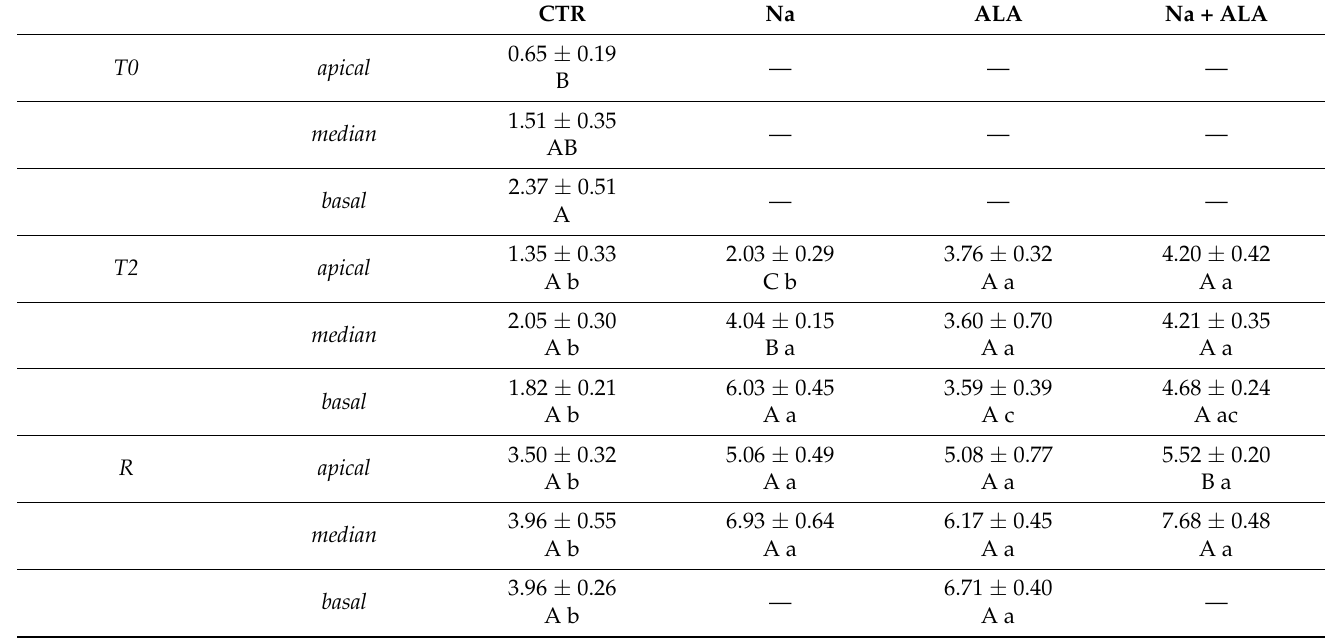
Table 4. Concentration of 5-aminolevulinic acid (ALA) ( µ g/g) measured at different time points (T0, T2, and R) in apical, median, and basal leaves of Arundo donax controls (CTR), salt-stressed (Na), ALA-treated (ALA), and both salt-stressed and ALA-treated (Na + ALA) plants. Mean values ± SE are shown. At any time-point, uppercase letters indicate statistically significant differences between (apical, median, and basal) leaves of plants undergoing the same treatment, and lowercase letters indicate statistically significant differences between (apical, median, and basal) leaves of plants undergoing different treatments ( p < 0.05; n =